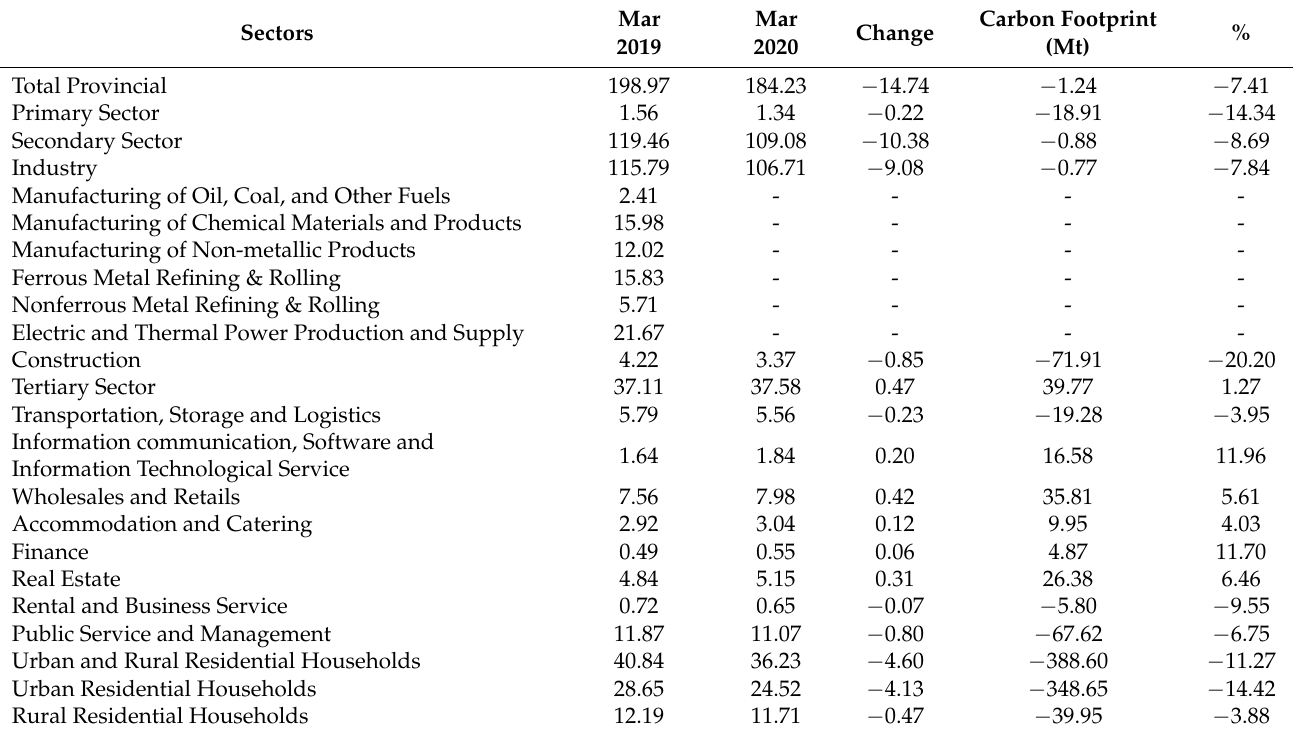
Table 6. Hubei sectoral carbon footprint changes of January 2020 compared to January 2019.